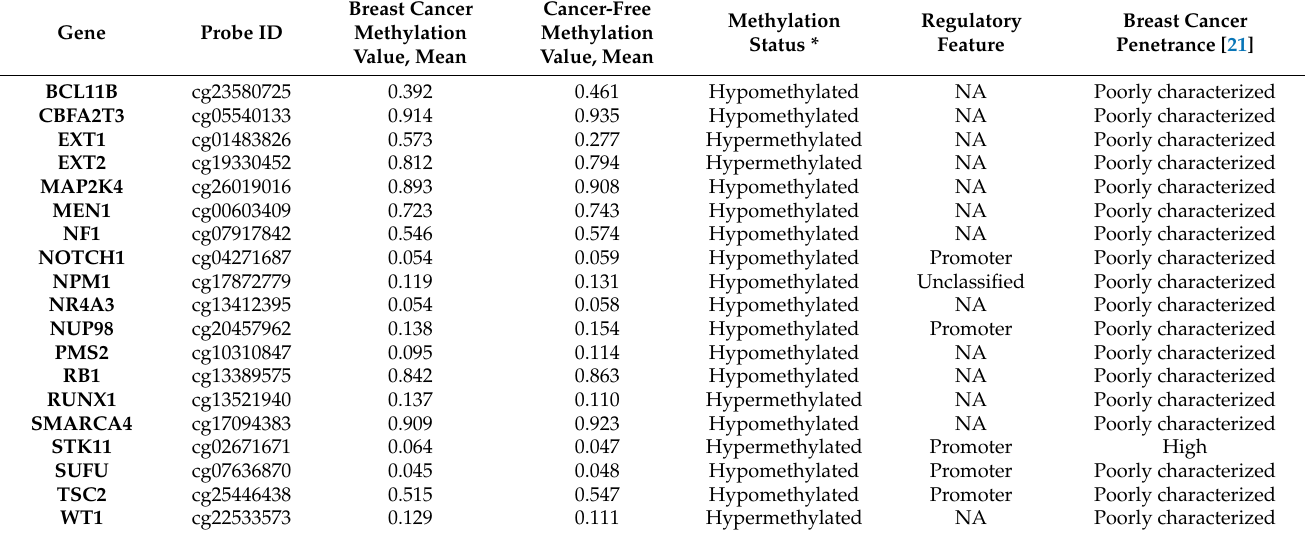
Table 5. Methylation status of differentially expressed known tumor suppressor genes in the WTC- exposed (WTC EHC) breast cancer cases compared to WTC EHC cancer-free